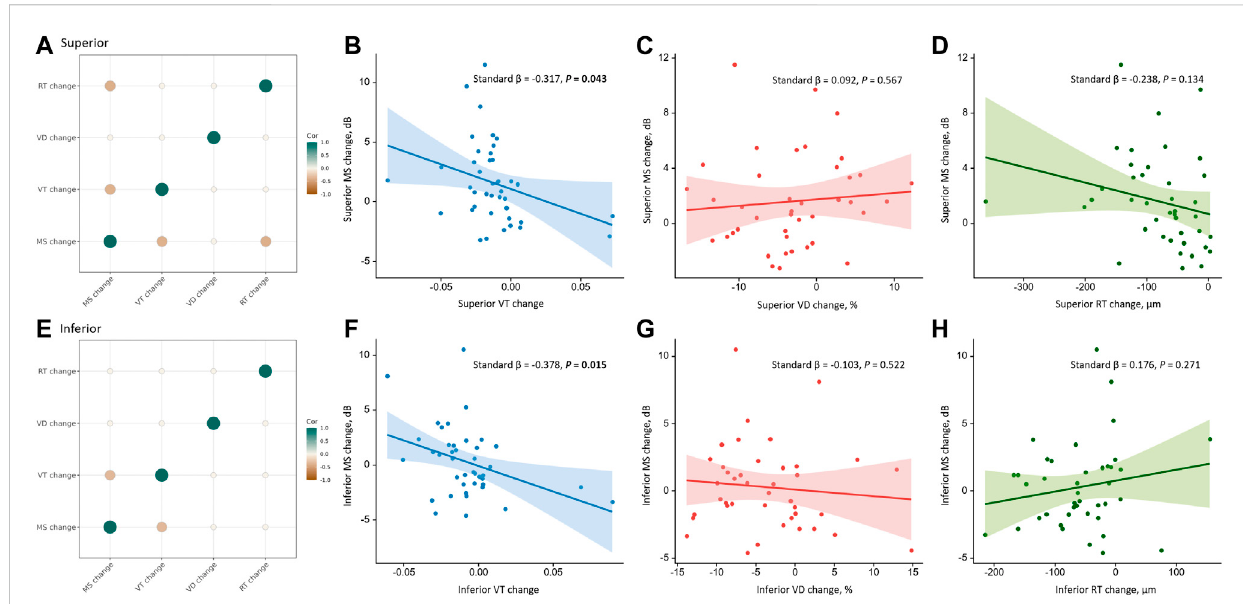
FIGURE 3 CorrelationsbetweenthechangesinanatomicalparametersandthechangeinMSinthesuperiorandinferiorquadrantsduringthe3-monthfollow- up. The fi rst column shows correlations among the changes in anatomical parameters and MS in the superior (A) and inferior (E) quadrants using Spearman ’ s Rho correlation. The color and size of the circle re fl ect the correlation tendency, degree, and signi fi cance. Only signi fi cant correlations with p < 0.05 are shown. The fi rst row shows correlations of VT change (B) , VD change (C) , and RT change (D) with MS change in the superior quadrant using univariate linear regression. The second row shows correlations of VT change (F) , VD change (G) , and RT change (H) with MS change in the inferior quadrantusingunivariatelinearregression.Thesolidlinerepresentstheregressionline,andthedashedlinesrepresentthe95%con fi denceintervalofthe regression line. Abbreviations: VT, vessel tortuosity; VD, vessel density; RT, retinal thickness; MS, mean